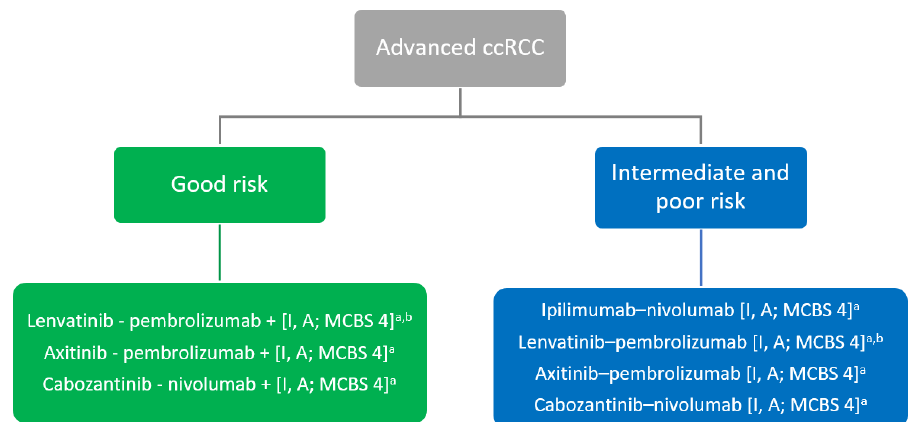
Figure 1. ESMO Clinical Practice Guideline update: Systemic first-line treatment of clear cell renal cell carcinoma (ccRCC) [14]. ccRCC, clear cell renal cell cancer; EMA, European Medicines Agency; ESMO- MCBS, European Society for Medical Oncology-Magnitude of Clinical Benefit Scale; FDA, Food and Drug Administration; IMDC, International Metastatic RCC Database Consortium; MCBS, ESMO-Magnitude of Clinical Scale; VEGFR, vascular endothelial growth factor receptor. a ESMO-MCBS v1.1 score for new therapy/indication approved by the EMA or FDA. The score has been calculated by the ESMO-MCBS Working Group and validated by the ESMO Guidelines Committee; b FDA approved; not currently EMA